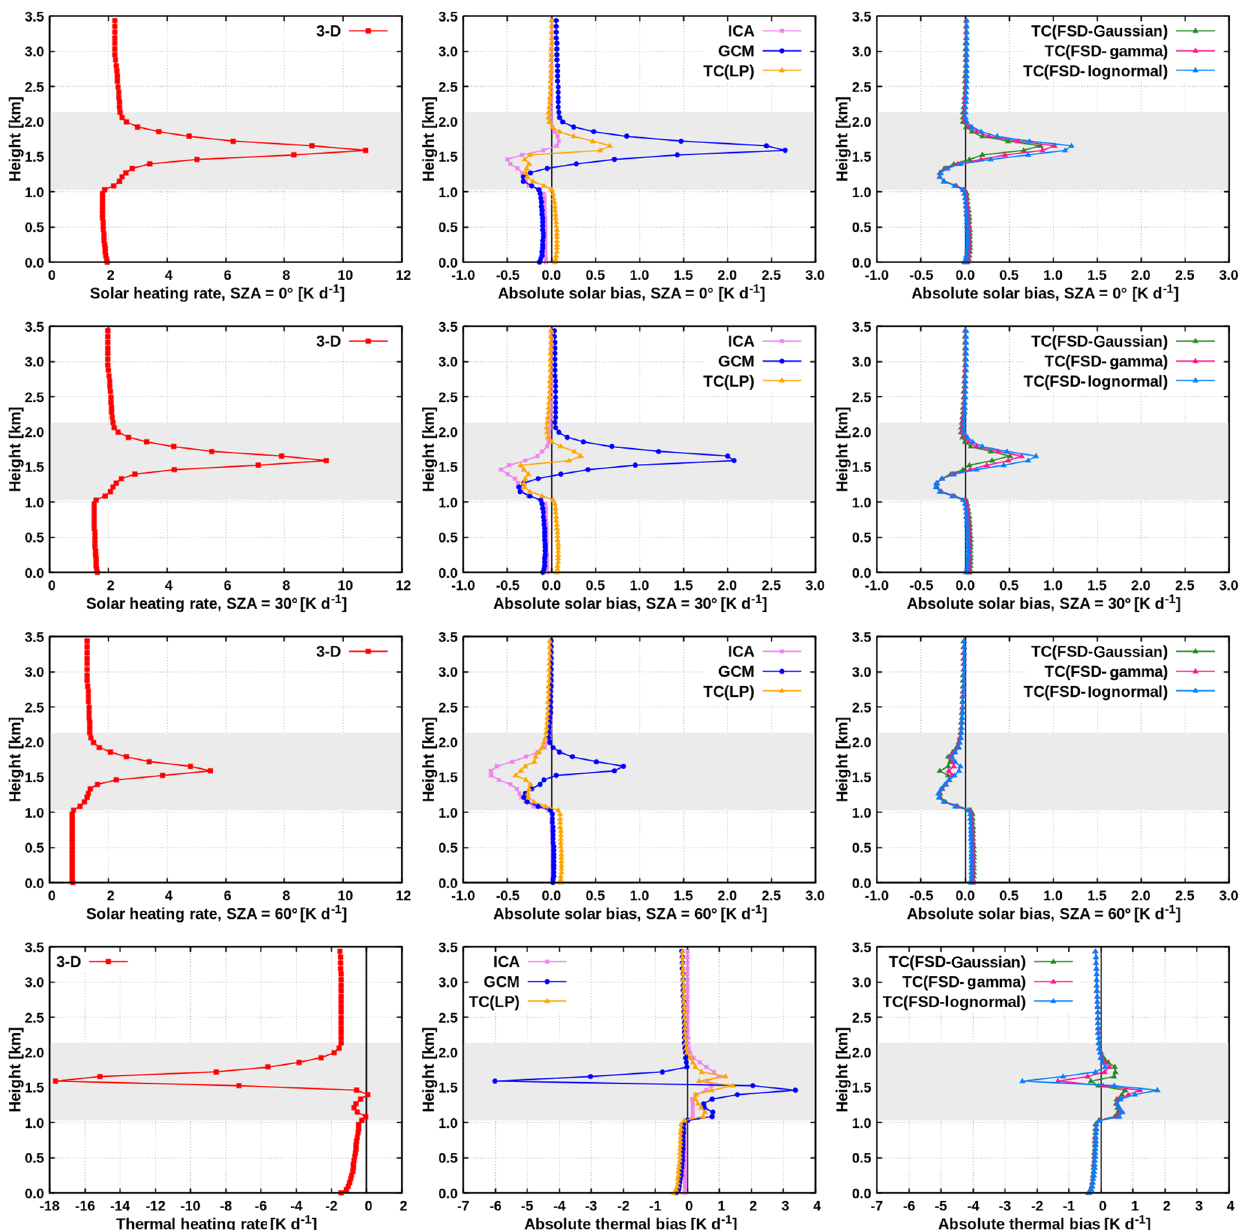
Figure 12. Left: benchmark radiative heating rate. Middle and right: bias for the ICA, GCM and TC